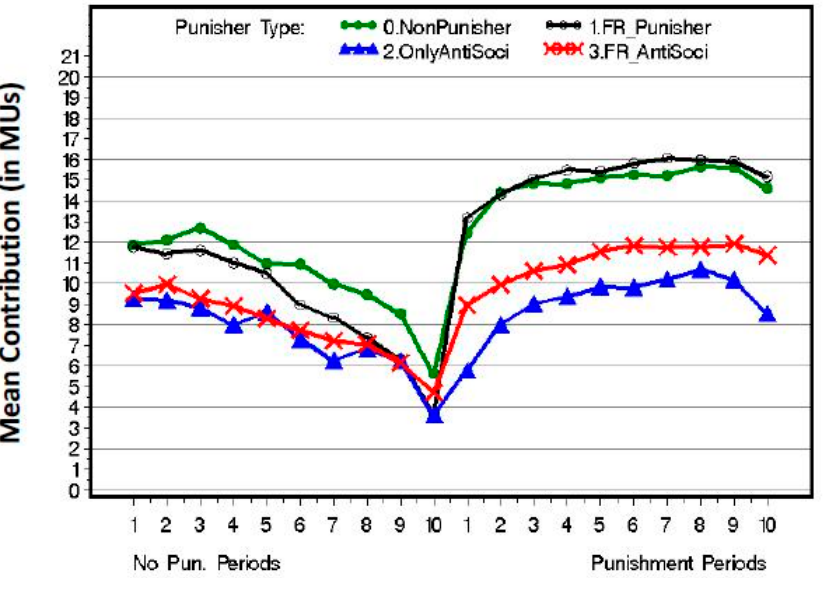
Figure 4. Mean contributions of punisher types in the no-punishment and punishment phases.